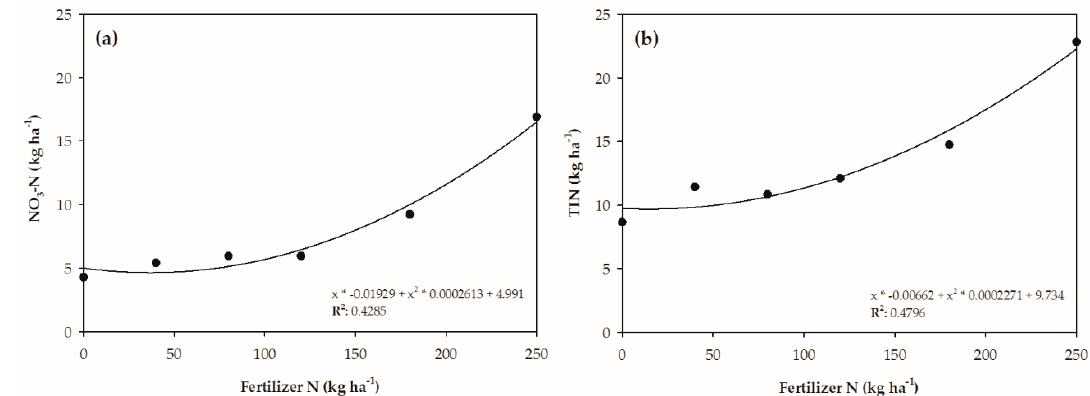
Figure 6. ( a ) response of post-harvest soil NO 3 -N and ( b ) total inorganic nitrogen (NO 3 -N + NH 4 -N, TIN) to fertilizer nitrogen (N) rate for second-year maize, across 2017 and 2018.